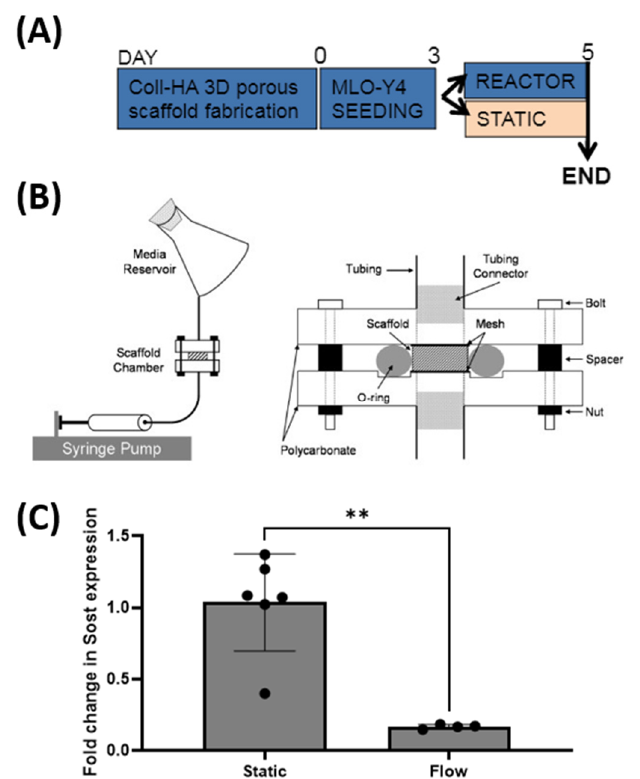
Figure 6. ( A ) Timeline for flow stimulation experiment. ( B ) Schematic of flow perfusion reactor. ( C ) Sost expression by MLO-Y4 cells cultured collagen-HA scaffold subjected to flow stimulation versus statically cultured. Sost expression decreased significantly upon flow stimulation (**, p < 0.01).